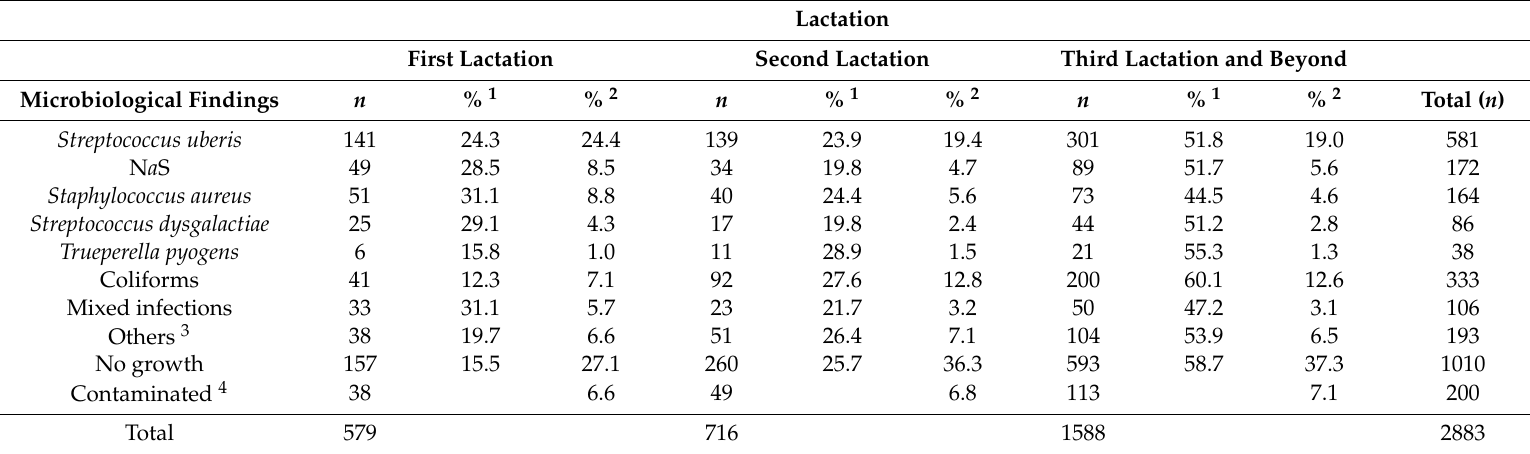
Table 4. Microbiological results based on conventional diagnostic methods ( n = 2883 mastitic udder milk samples) and their distribution by lactation number.